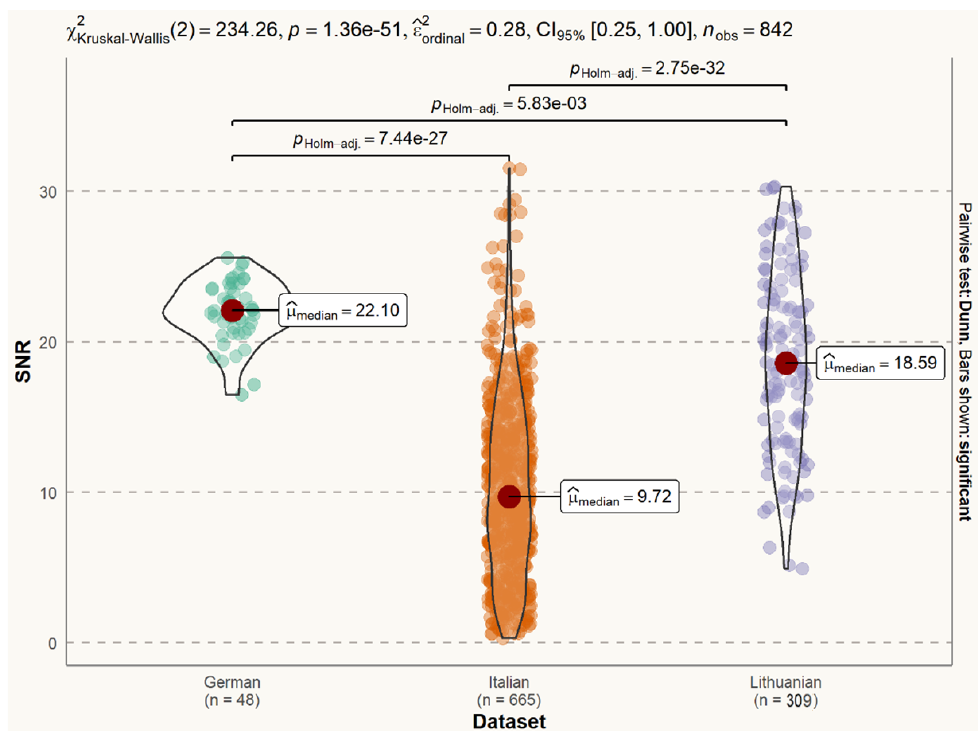
Figure 6. Statistical distribution of voice signal SNR in datasets. The difference between the German and Italian datasets is statistically significant ( p < 0.001). The difference between the German and Lithuanian datasets is statistically significant ( p < 0.01). The difference between the Italian and Lith- uanian datasets is statistically significant ( p < 0.001).